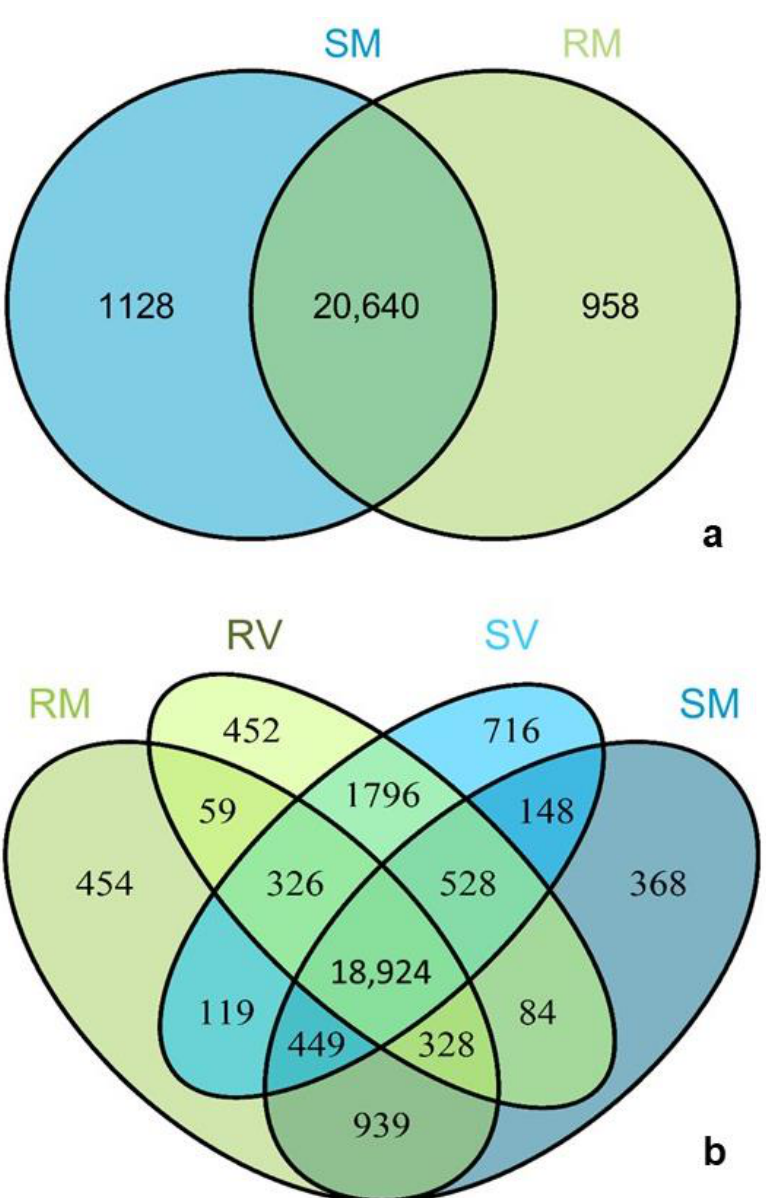
Figure 1. Venn diagrams showing sample-specific transcript analysis considering only the transcripts with length ≥ 150 bp and a threshold of RPKM ≥ 1 for a transcript to be considered as active. ( a ) Full maturation samples under regulated deficit irrigation (RM) and under sustained deficit irrigation (SM); ( b ) samples of regulated deficit irrigation maturation (RM); regulated deficit irrigation v é raison (RV); sustained deficit irrigation maturation (SM) and sustained deficit irrigation v é raison (SV).